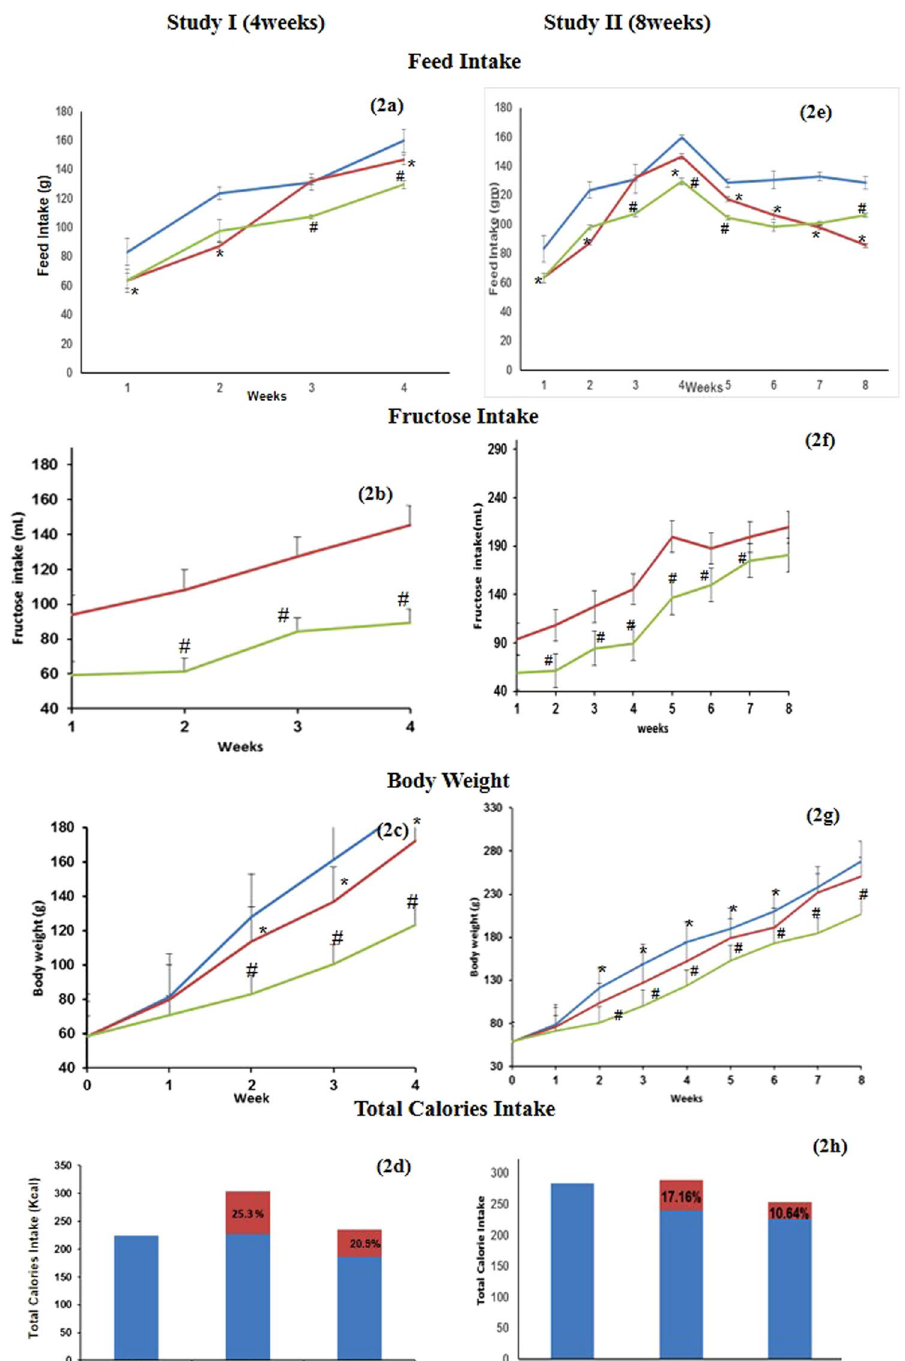
Figure 2. Comparison of weekly feed intake, fructose intake, body weight and total calorie intake, after 4 weeks(study I) and 8 weeks (study II) of fructose ingestion. The feed intake, fructose intake, body weight and total calorie intake at developing ( a–d ) and adulthood ( e–h ) stages in normal (blue line), fructose-control (red line) and AM-HM (green line) treated groups are represented. The feed and fructose intake were highest in NDR and lowest in AMR in studies I and II. The weight gain pattern was parallel in all the three groups with lowest gain in AMR and highest in NDR in studies I and II. The total caloric intake, in study I, was highest in FDR with about 25% sourced from fructose. In study II, the total caloric intake, was equal in NDR and FDR with about 17% sourced from fructose in latter. All values are mean ± SEM; (n = 6), * p < 0.05 vs NDR, # p < 0.001 vs